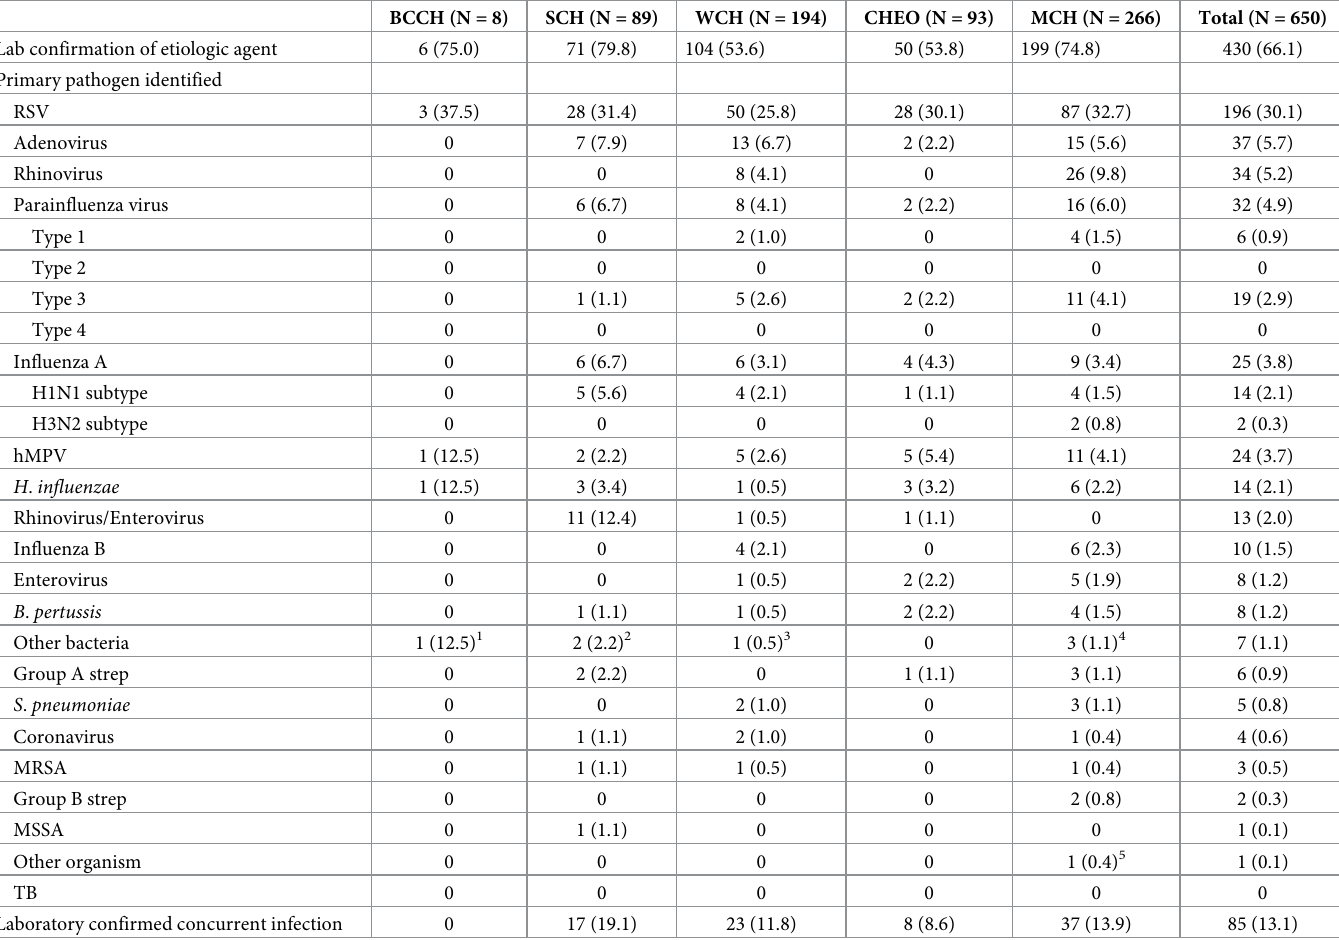
Table 4. Microbiology results of 650 children transported urgently by air from northern Canada to five tertiary care centers (n,